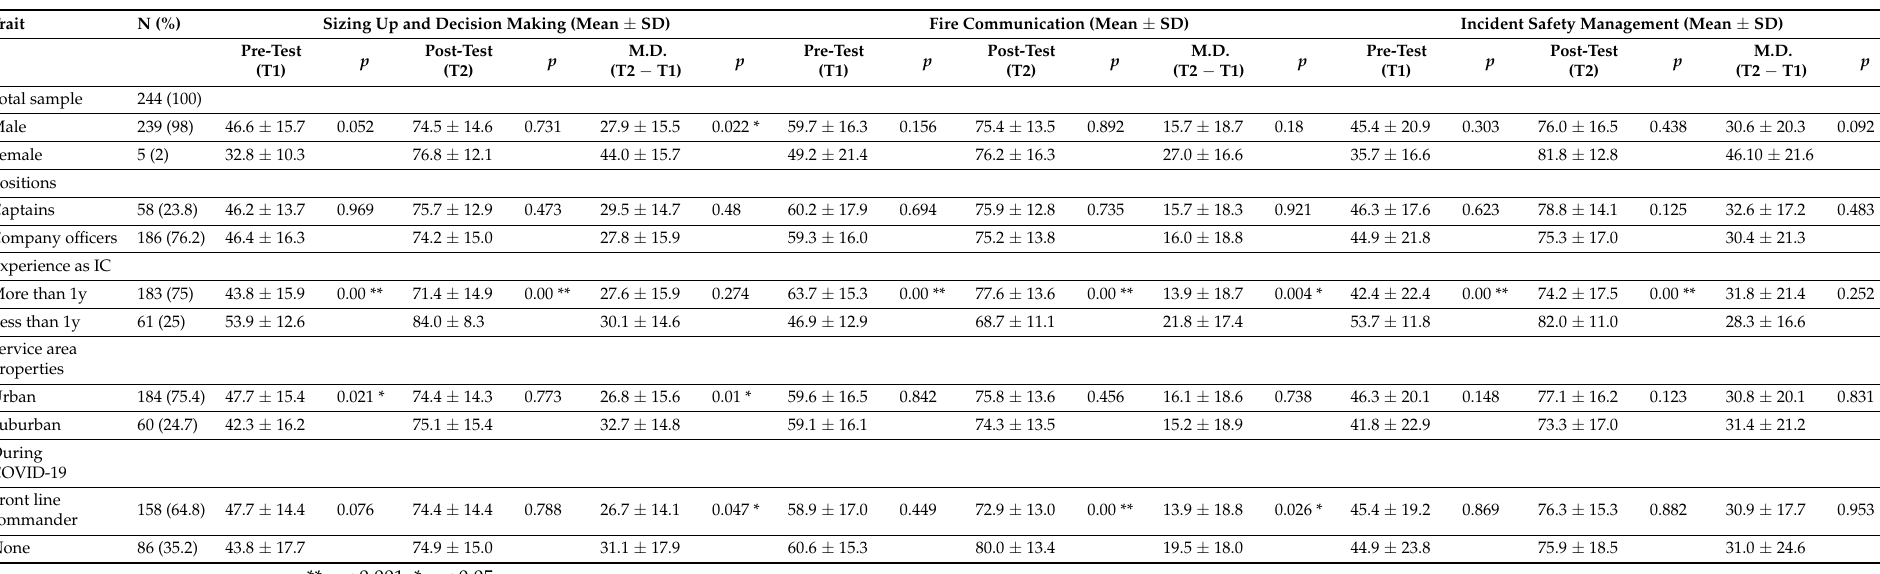
Table 5. The objective evaluation score (mean ± SD) was obtained by the total sample ( n = 244) passing the pre-experiment/post-experiment test and then divided into groups according to the trainee’s professional title, service attributes, and personal characteristics to perform the independent sample T test between each